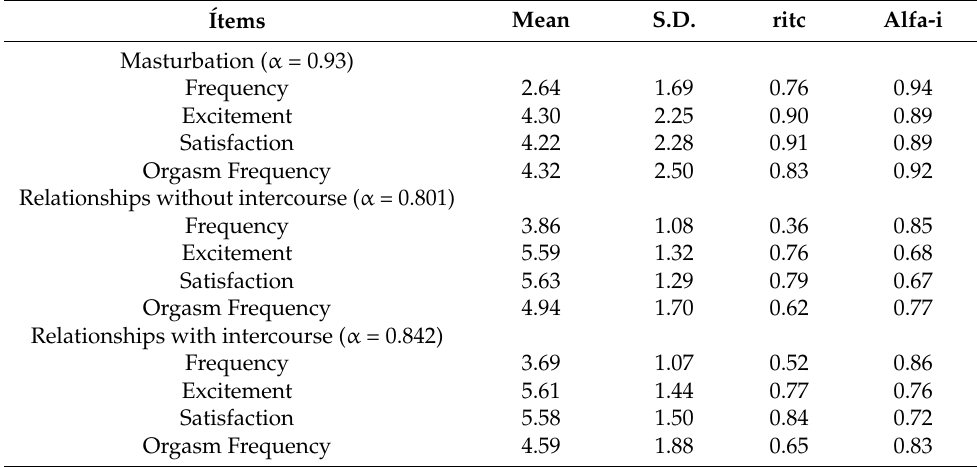
Table 2. Item analysis and internal consistency of